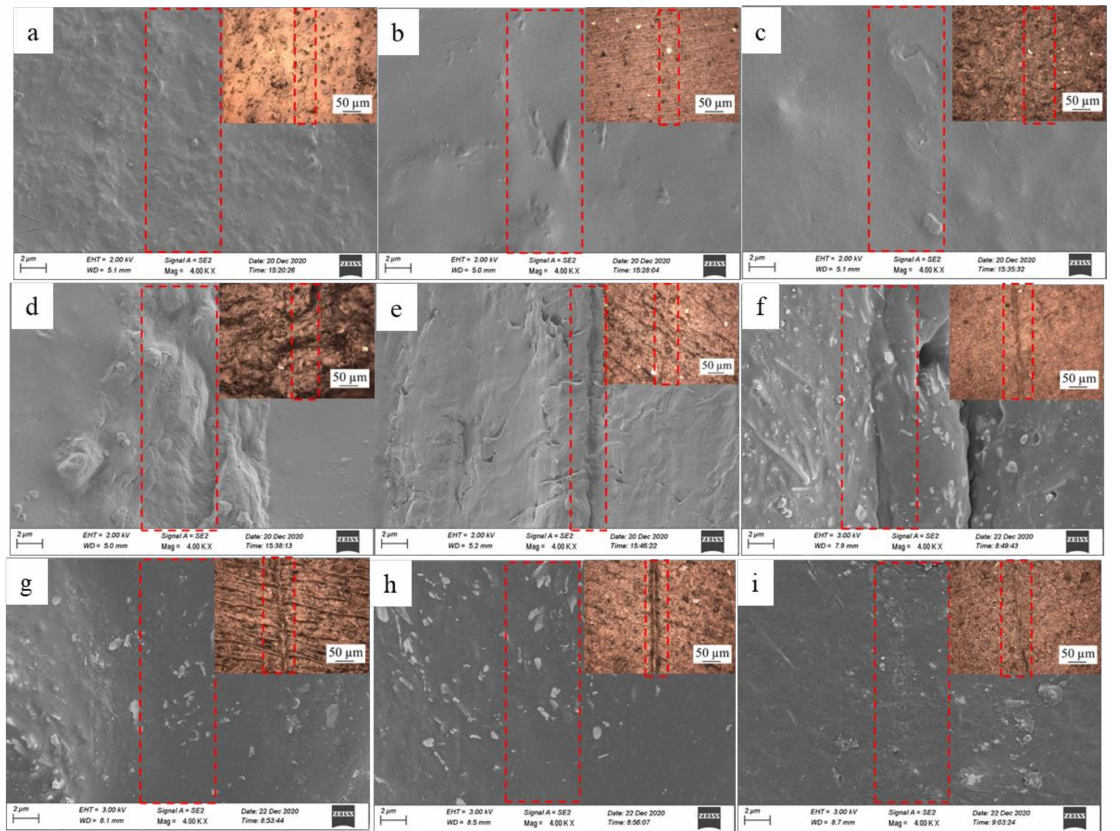
Figure 11. SEM images of self-healing composite films with the AgNWs-RGO mass contents of 0 wt% ( a ), 5 wt% ( b ), 10 wt% ( c ), 15 wt% ( d ), 20 wt% ( e ), 25 wt% ( f ), 30 wt% ( g ), 35 wt% ( h ), and 37 wt% ( i ). The insets are optical microscope photographs.